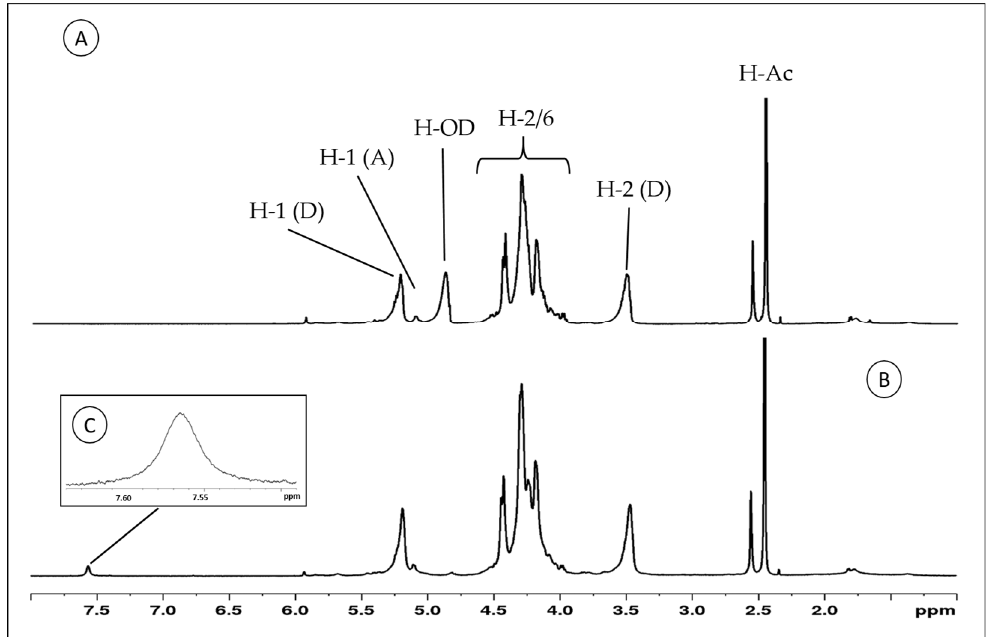
Figure 4. Proton-nuclear magnetic resonance ( 1 H-NMR) spectra of Chit-F and Chit-FGal. ( A ) Chit-F spectra ( B ) Chit-FGal spectra ( C ) 7.57 Chit-FGal sign highlighted indicates regions where aromatic compounds are found. These spectra are representative of three independently performed analyses.